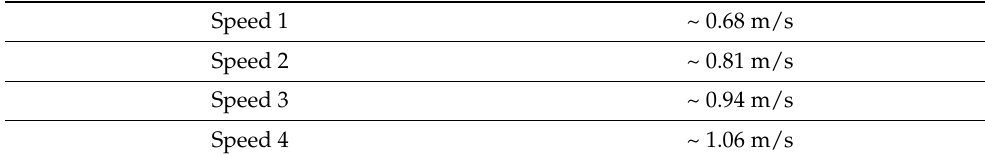
Table 3. Applied speed levels and the average velocities of these speed